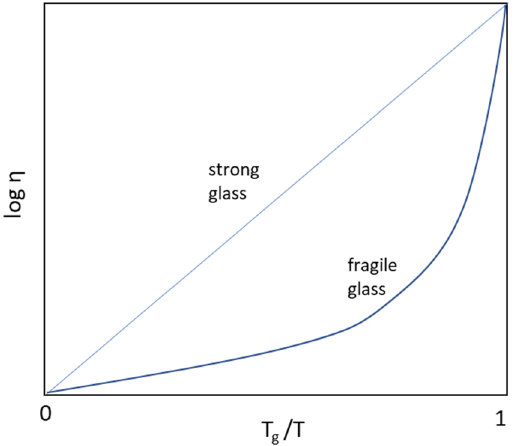
Figure 5. A schematic description of strong (Arrhenius type) and fragile (non-Arrhenius type) glass formers.